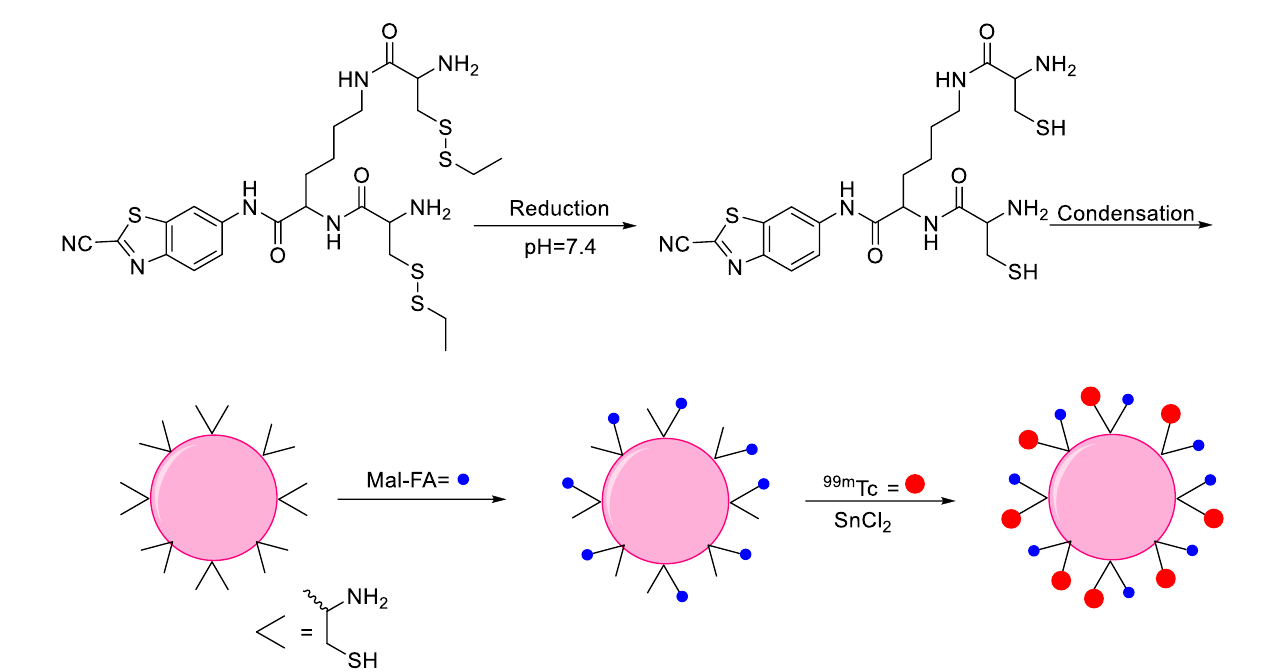
Figure 13. Synthesis of 99m Tc radiolabeled oligomer nanoparticles [74]. Table 3. Summary of 99m Tc-labeled organic nanoparticles and their applications.